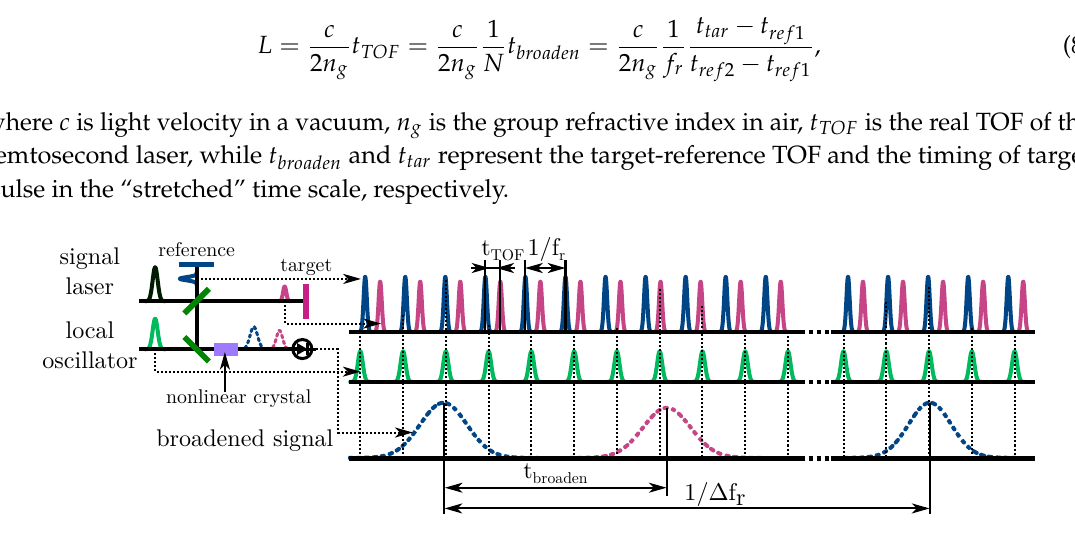
Figure 2. Principle of femtosecond laser ranging based on asynchronous optical